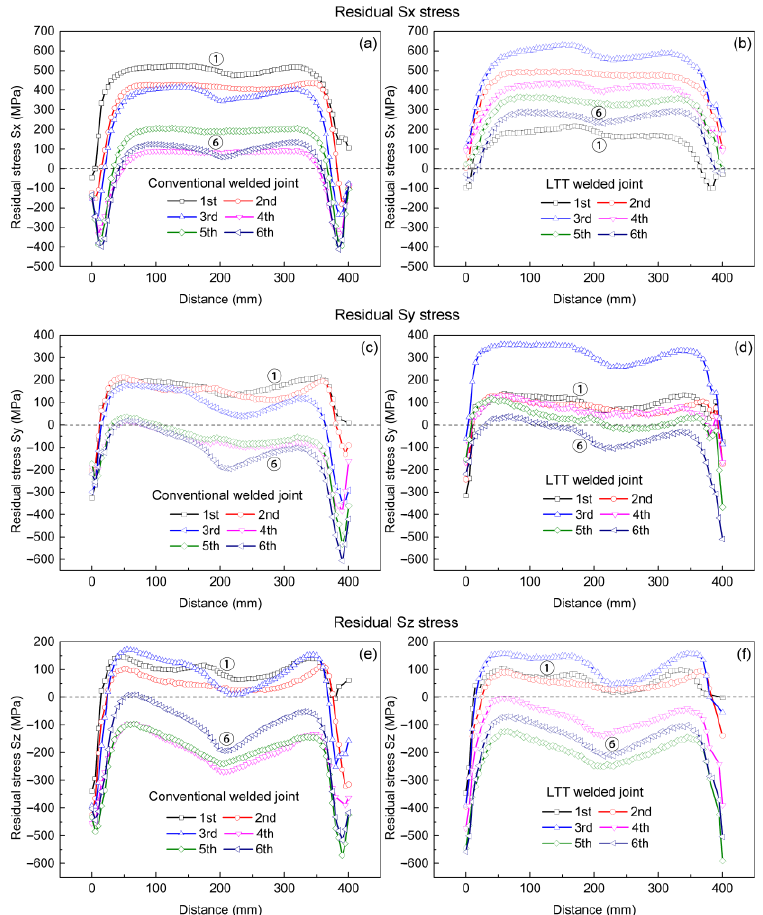
Figure 13. Simulated residual stress at the weld roots of the conventional and LTT welded joints after each welding: ( a ) residual Sx stress in conventional welded joint; ( b ) residual Sx stress in LTT welded joint; ( c ) residual Sy stress in con- ventional welded joint; ( d ) residual Sy stress in LTT welded joint; ( e ) residual Sz stress in conventional welded joint; ( f ) residual Sz stress in LTT welded